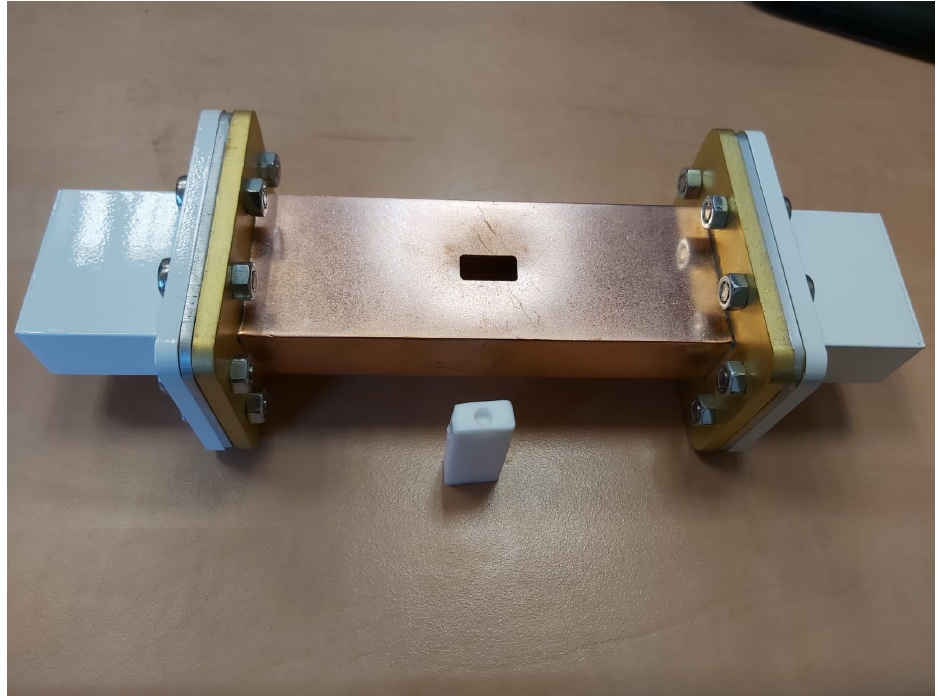
Figure 9. Resonator (WR187 waveguide with mirrors at the edges) for the 3.95–5.85 GHz frequency